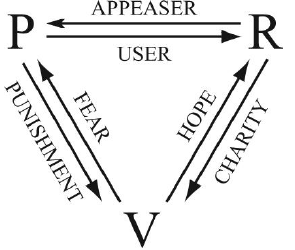
Figure 5: The Sex Games Triangle.